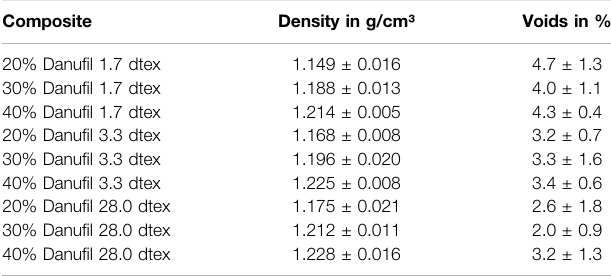
TABLE 1 | Density and voids of the different Danu fi l fi bre-reinforced composites (mean values ± SD). Composite Density in g/cm³